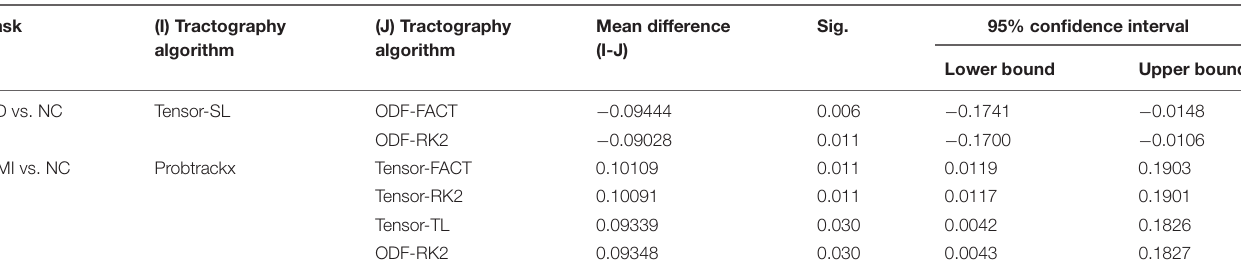
TABLE 6B | Post hoc group